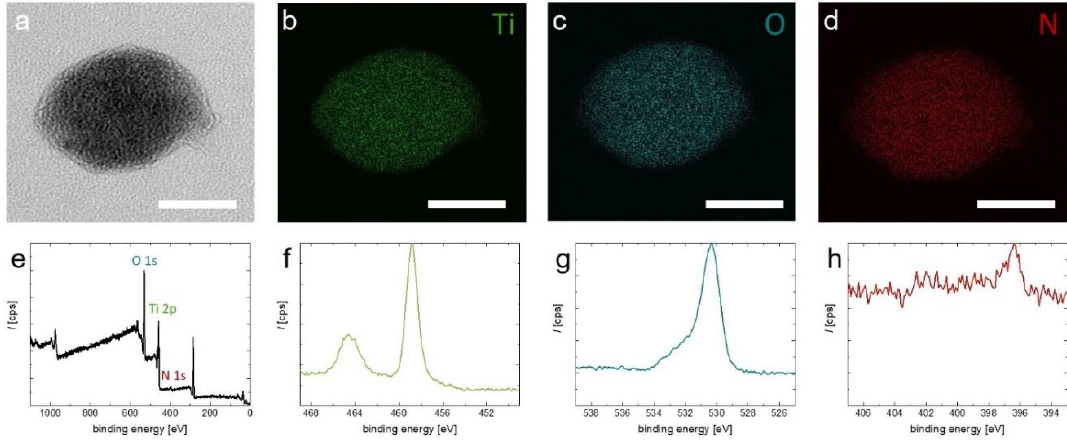
Figure 3. ( a – d ) EELS mapping of a TiON nanoparticle. ( a ) TEM image of the analyzed particle. ( b – d ) Elemental mapping of titanium, oxygen, and nitrogen, respectively; ( e – h ) XPS spectra of the synthesized TiON nanoparticles. Image ( e ) shows a full scan; images ( f – h ) show the spectra regions of Ti 2p, O 1s, and N 1s, respectively. The scale bars in ( a – d ) = 40 nm.